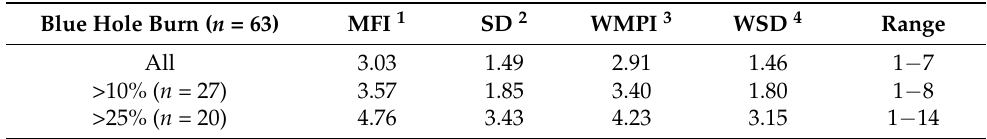
Table 1. Composite and filtered fire history statistics. Values are in years. Blue Hole Burn ( n = 63) MFI 1 SD 2 WMPI 3 WSD 4 Range All